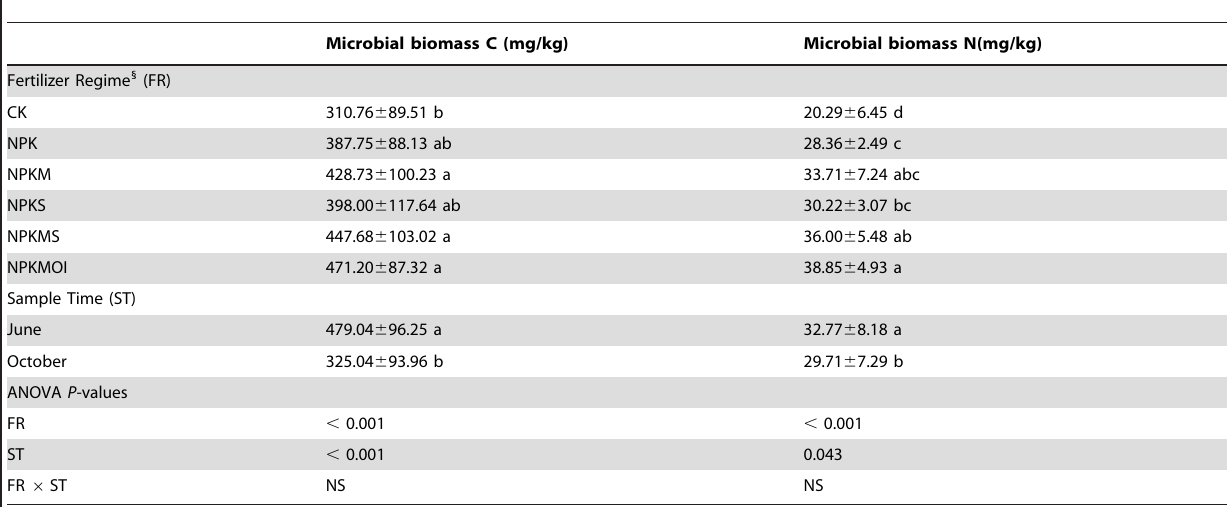
Table 2. Effects of fertilizer regime, sample time and the interaction between them on soil microbial biomass carbon and